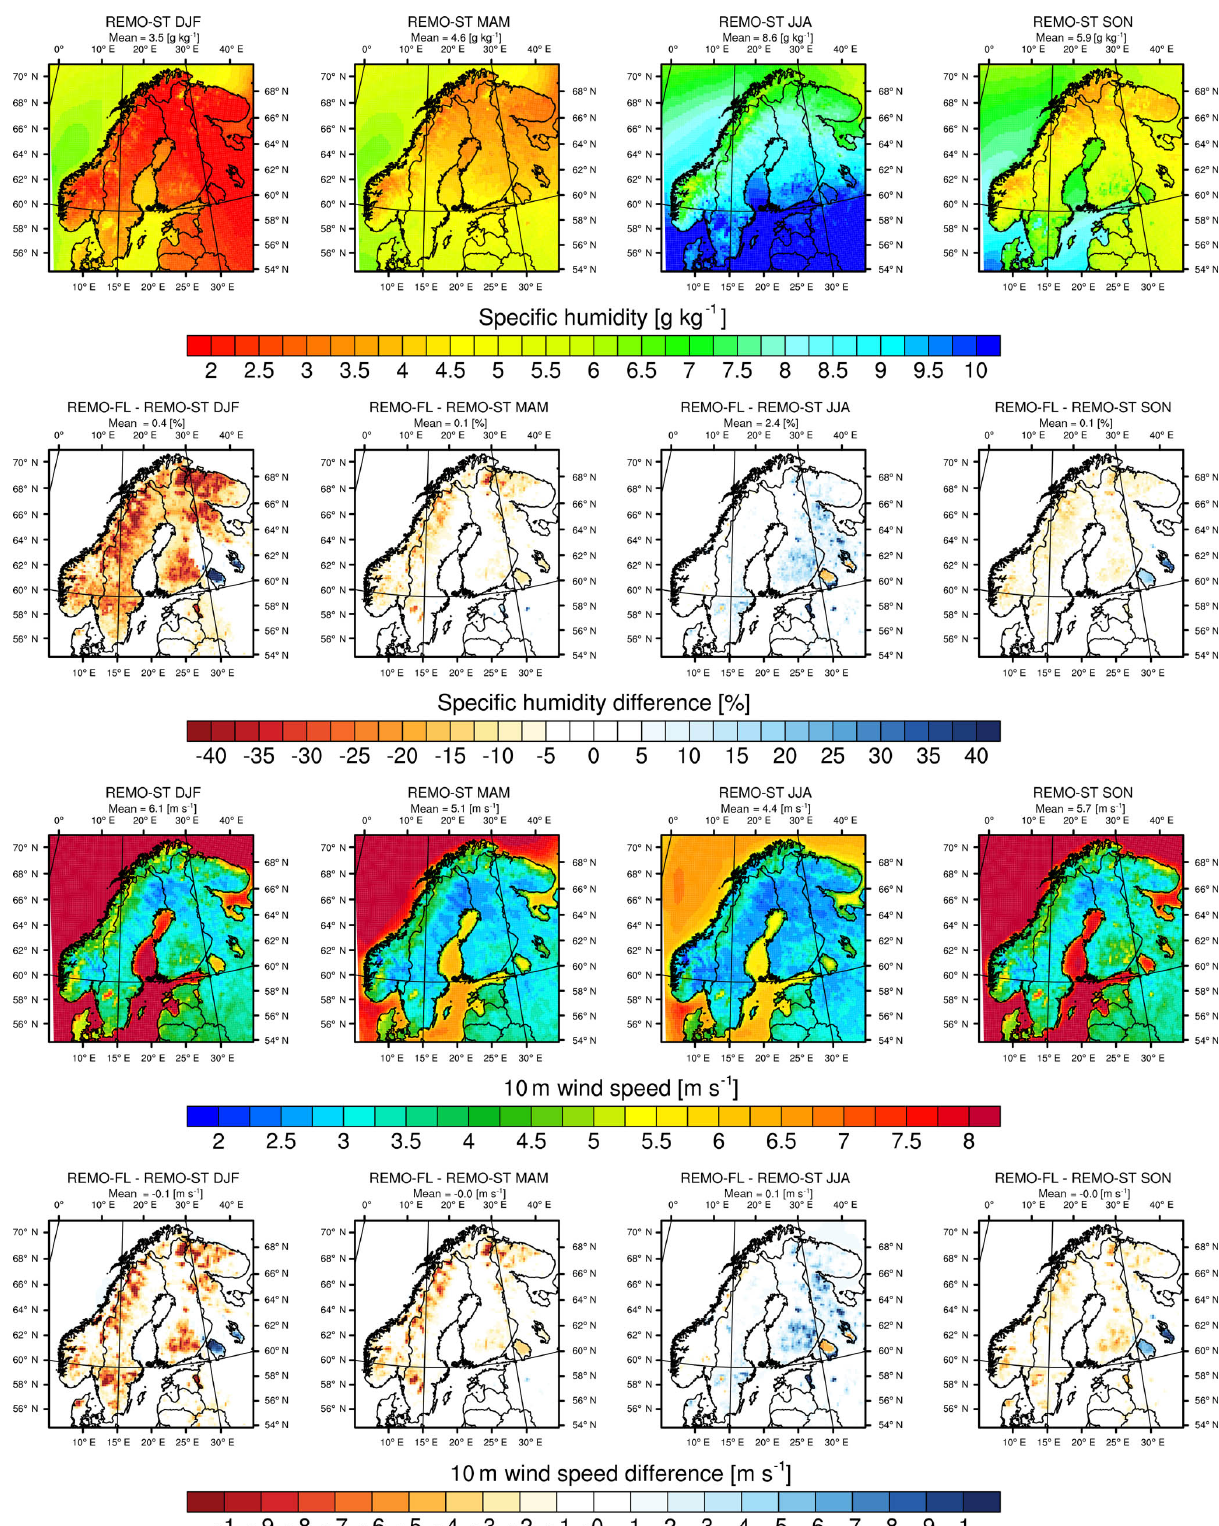
Figure 4. Specific humidity at the surface and 10m wind speeds from standard REMO (REMO-ST) and the difference between REMO with the FLake module (REMO-FL) and REMO-ST. The seasonally averaged results are for the time period of October 1979–March